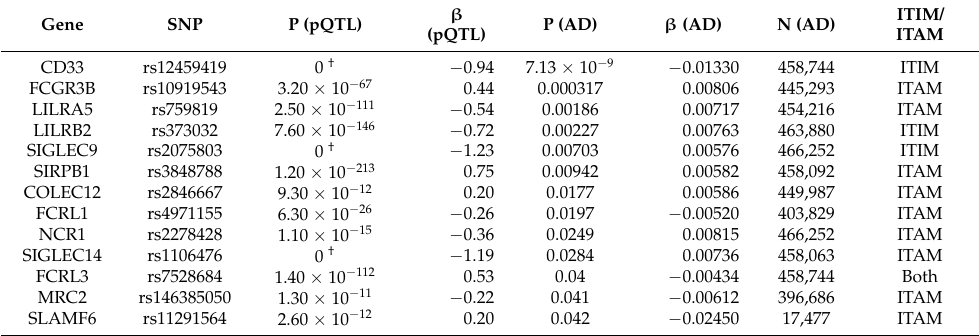
Table 1. Genes that are nominally significant for AD association with strong pQTL signal.